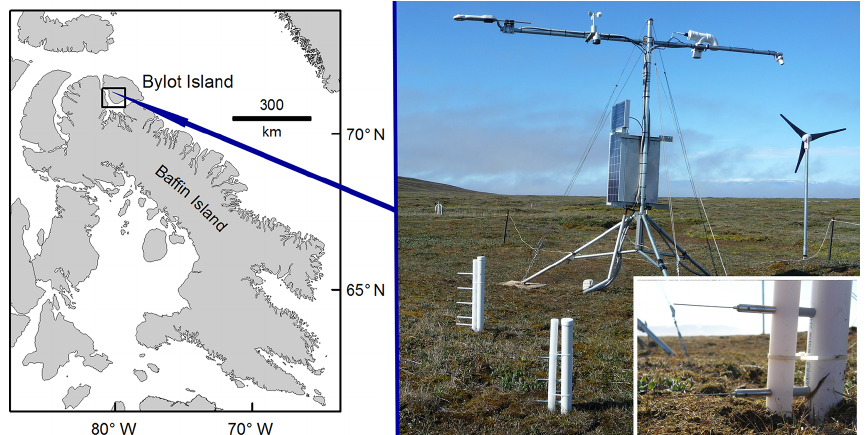
Figure 1. Location of the study site on Bylot Island in the Canadian Arctic archipelago and photograph of the monitoring station deployed. The polyethylene post with the three TP08 heated needle probes is in the foreground. The polyethylene post with the five thermistors is visible behind it. The radiometers, SR50 snow height gauge, cup anemometer, temperature and relative humidity gauge, and surface temperature sensors are visible on the tripod, from left to right. The CR1000 data loggers and batteries are in the metal box on the tripod. Batteries are recharged by solar panels and a wind mill in winter. Inset: detail of the lower two TP08 needles after their positions were lowered in July 2014.